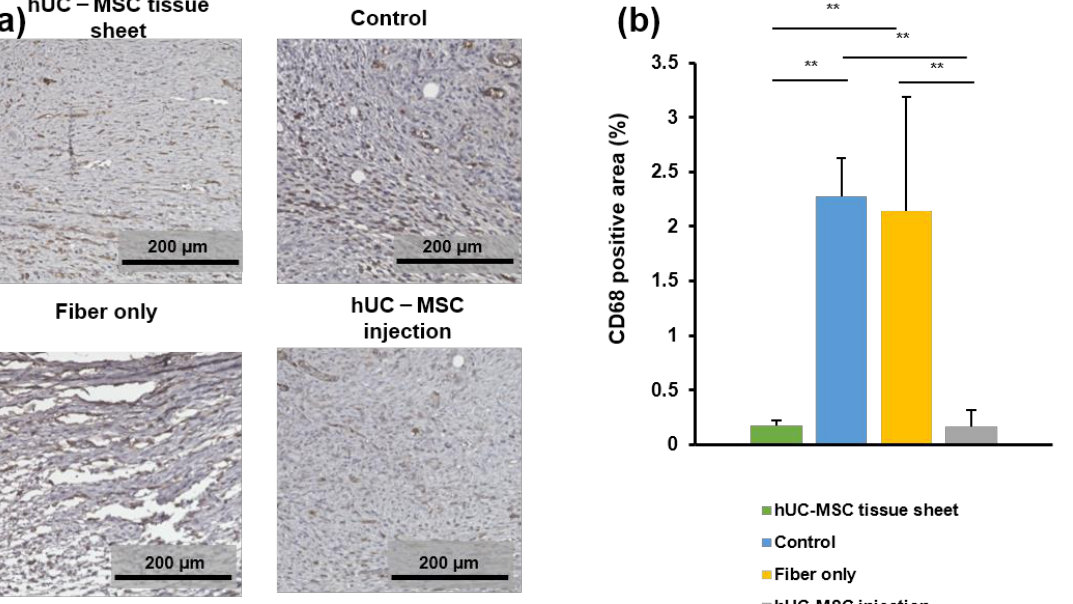
Figure 6. The human umbilical cord mesenchymal stem cell (hUC-MSC) tissue sheet regulates inflammation response in diabetic wounds. ( a ) Representative images of immunohistochemical sections in different groups on day 14 after wounding. Scale bar = 200 µ m. ( b ) Quantitative analysis of immunohistochemical signals of CD68 in high power field images. In the fiber-only group, only the non-fiber area is analyzed. Results are presented as mean ± SD. Significance was determined using analysis of variance ANOVA. ** p < 0.01.